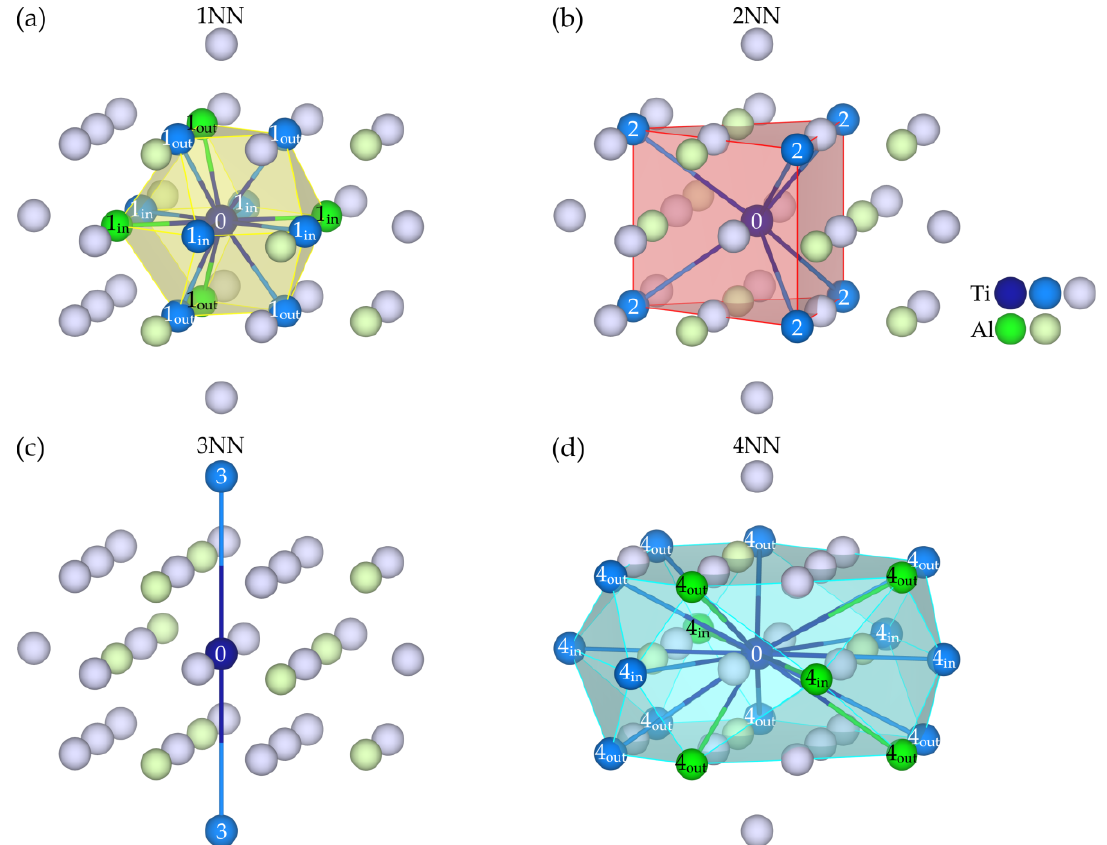
Figure 6. Considered coordination ellipsoids: the first ( a ), second ( b ), third ( c ), and fourth ( d ) ones. Table 2. Interatomic distances and their multiplicities for the first four coordination ellipsoids. Coordination